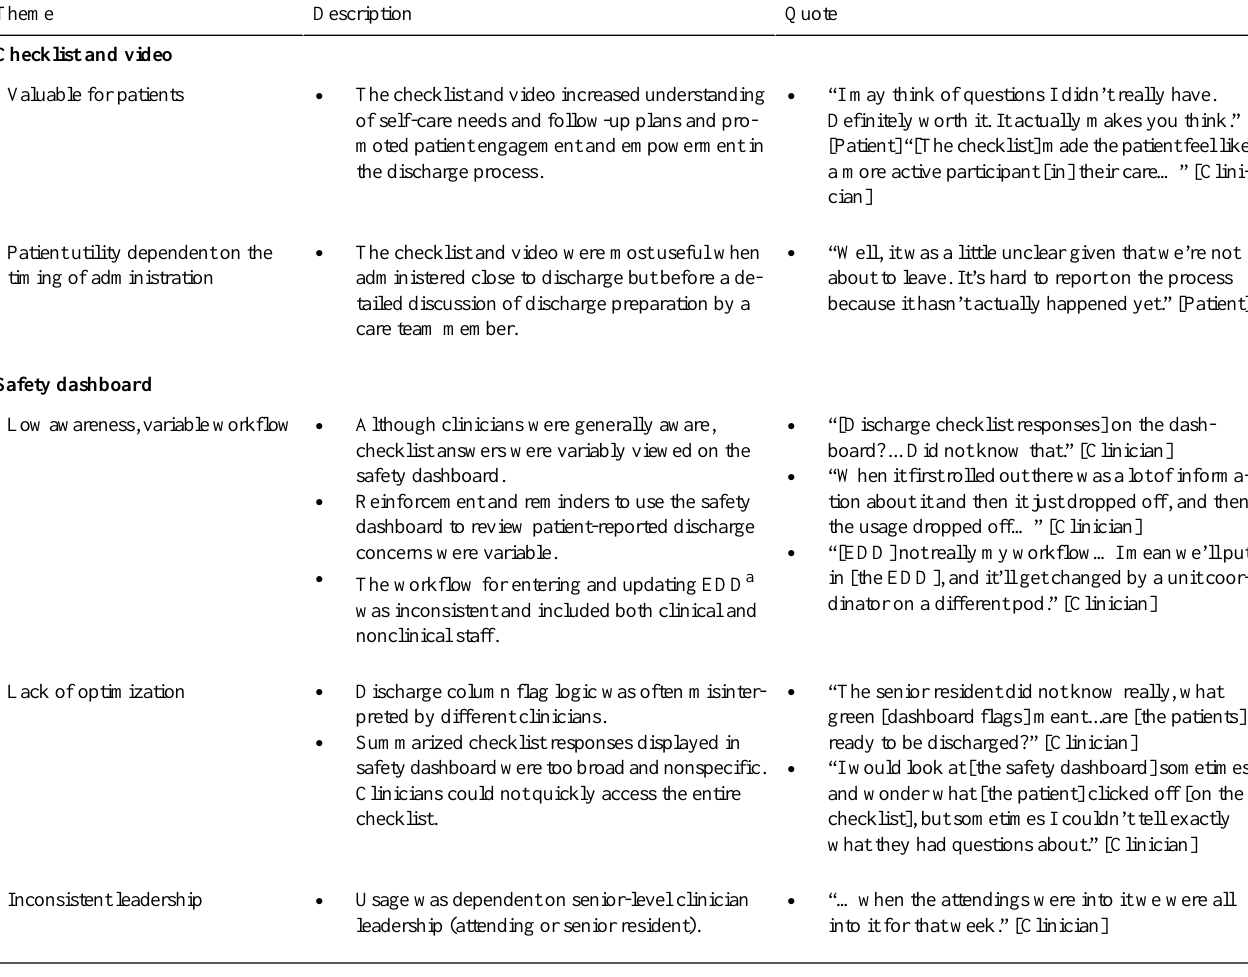
Table 5. Key themes from patient interviews and clinician focus groups about patient-centered discharge toolkit